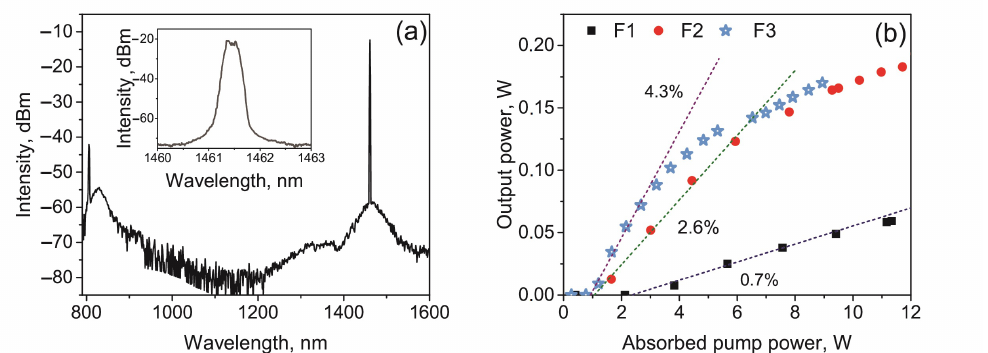
Figure 2. ( a ) Typical output emission spectrum of the developed BDFL with the FBG. (A laser line measured with a spectral resolution of 0.07 nm is depicted in the inset.) ( b ) Output power of BDFLs with the FBG as a function of the absorbed pump power, measured for fiber samples of a length L = 200